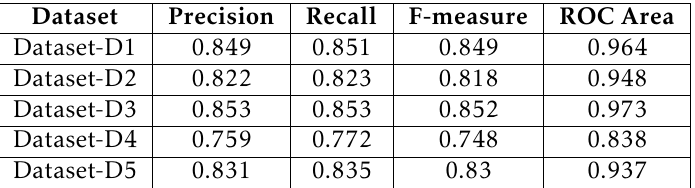
Table 4. The prediction results for Decision Tree